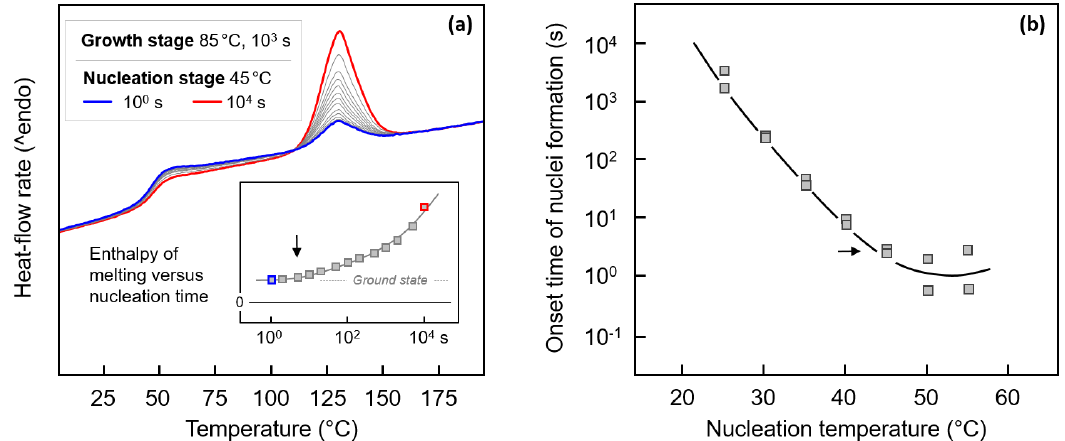
Figure 3. FSC heating curves, heat-flow rate as a function of temperature, of PBI, collected after subjecting PBI to Tammann’s nuclei development method (a) . The nucleation temperature was 45 °C and the nucleation time between 1 s (blue) and 10,000 s (red). The growth-stage temperature and time were 85 °C and 1000 s, respectively, and the transfer-heating rate, that is, the rate of heating the system from 45 °C to 85 °C, was 1000 K/s. The inset shows the enthalpy of melting as a function of the nucleation time at 45 °C. The right plot (b) shows the onset time of nuclei formation as a function of temperature.